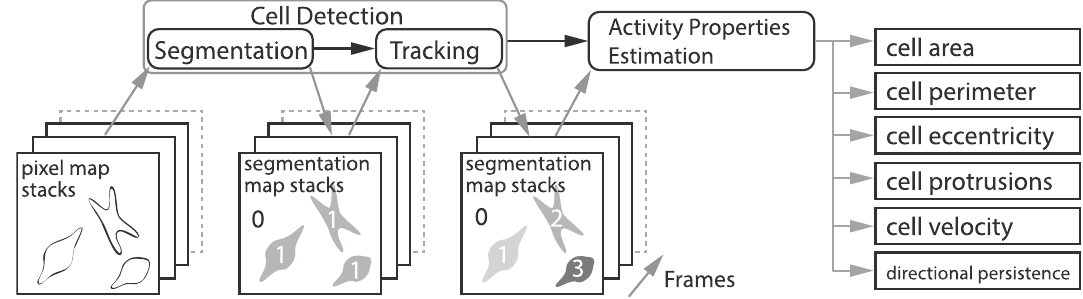
Figure 1. Implementation overview: schematic of the data processing procedure, producing scalar cell properties from a series of low-contrast cell images (pixel map